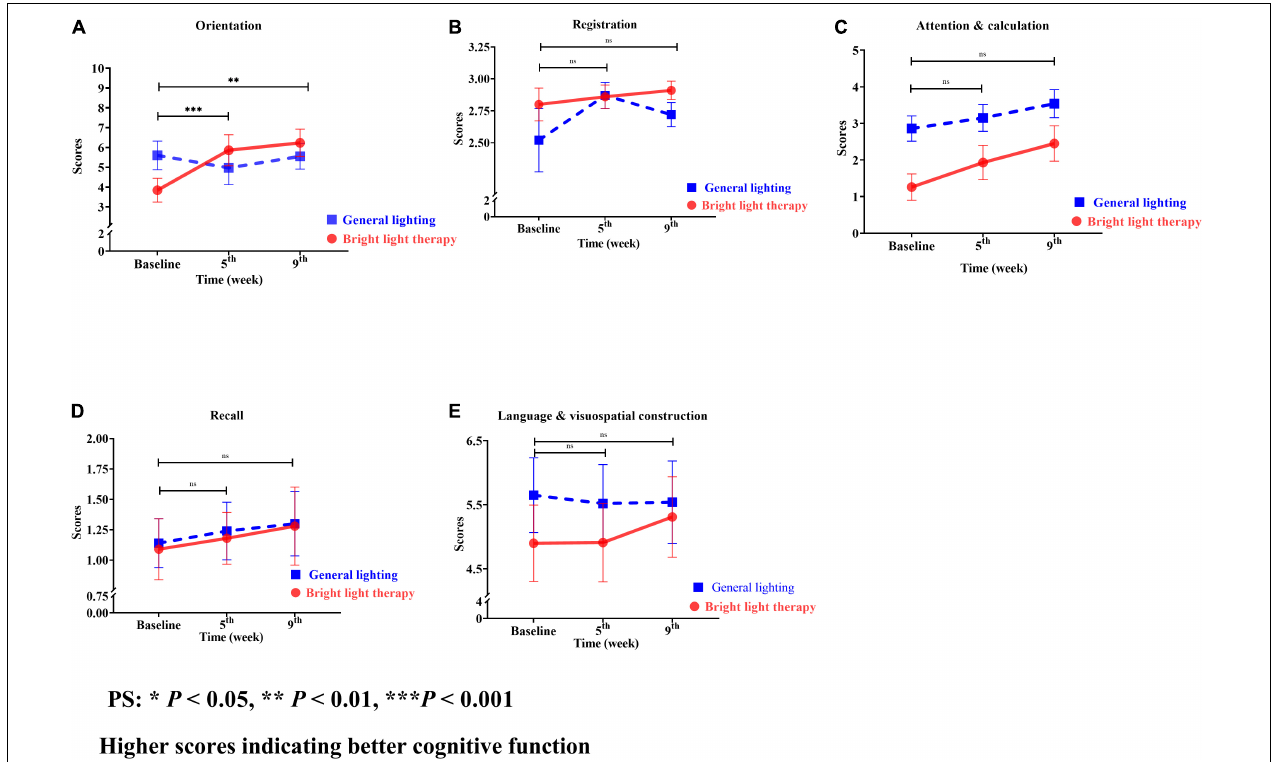
FIGURE 6 | (A) Orientation, (B) registration, (C) attention and calculation, (D) recall, and (E) language and visuospatial construction of the two groups at different time points. For both the experimental and comparison groups, the domain with the maximum change was orientation. The experimental group showed a significant improvement in orientation (Wald’s test = 10.1, P = 0.001; Wald’s test = 8.73, P = 0.003) from baseline to the 5th and 9th weeks compared with the comparison group (A)